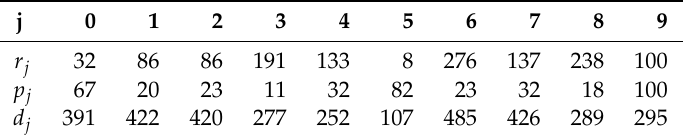
Table 1. Data of the instance N_12_10.